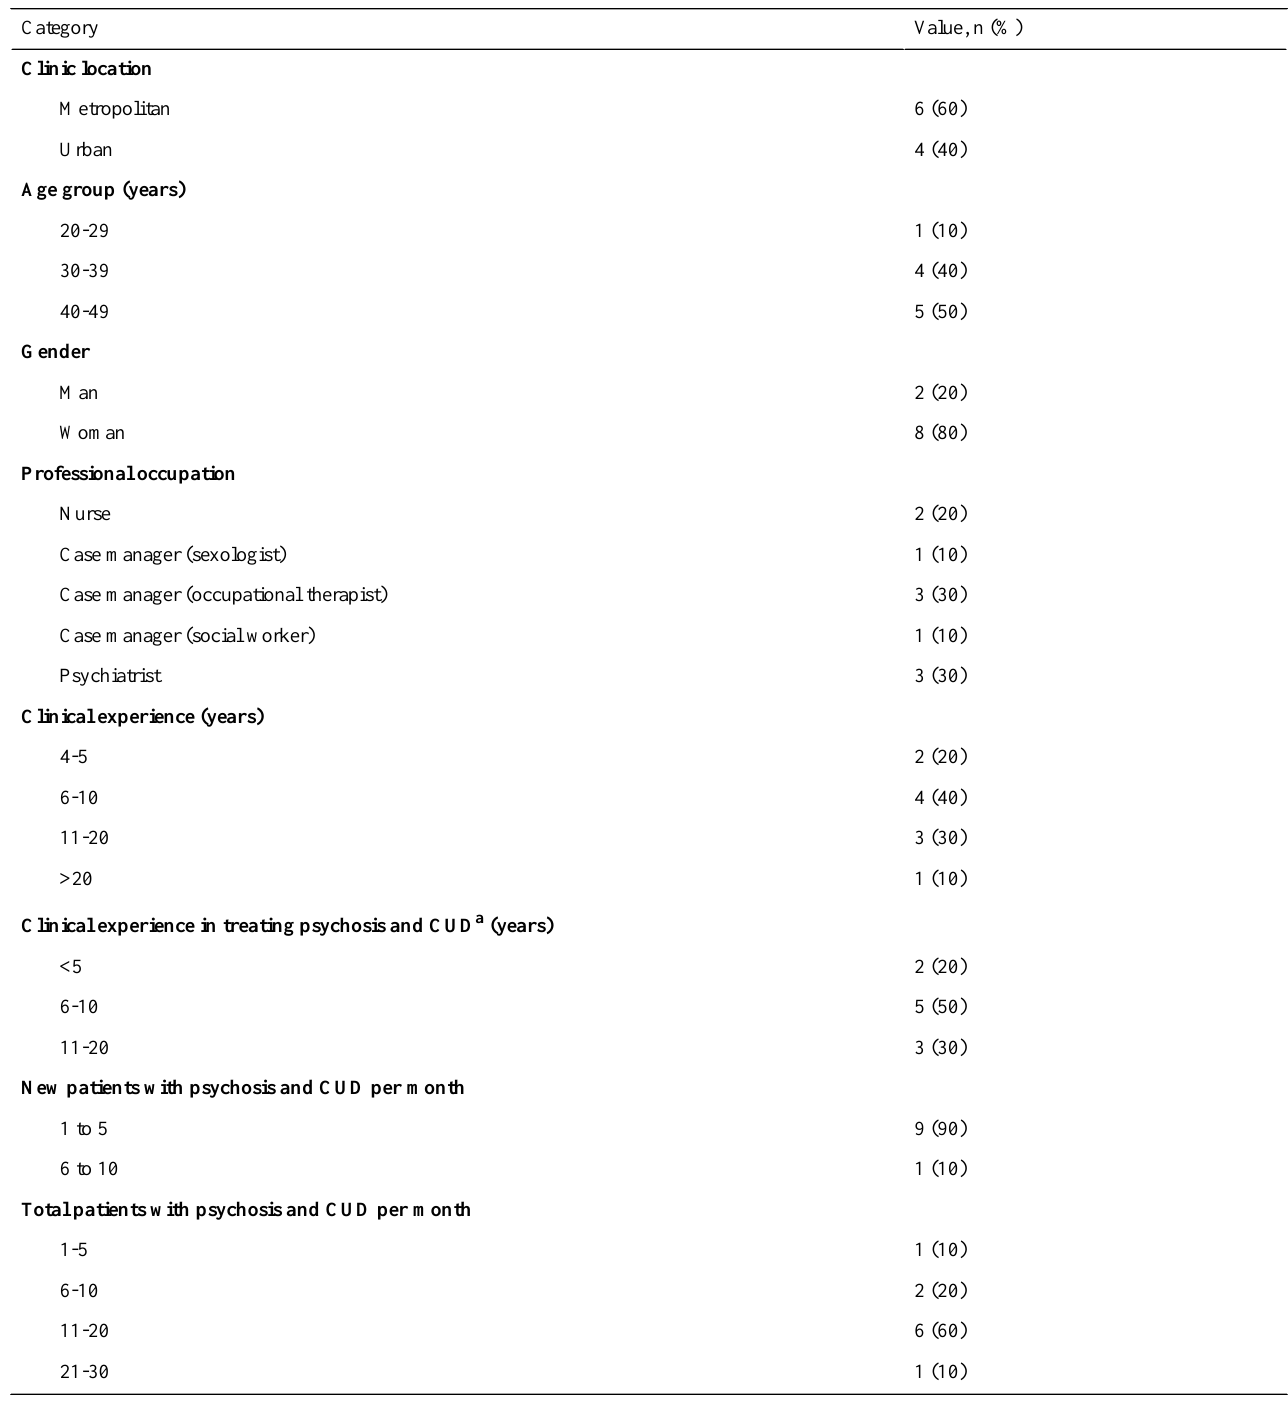
Table 2. Sociodemographic and professional characteristics of clinicians